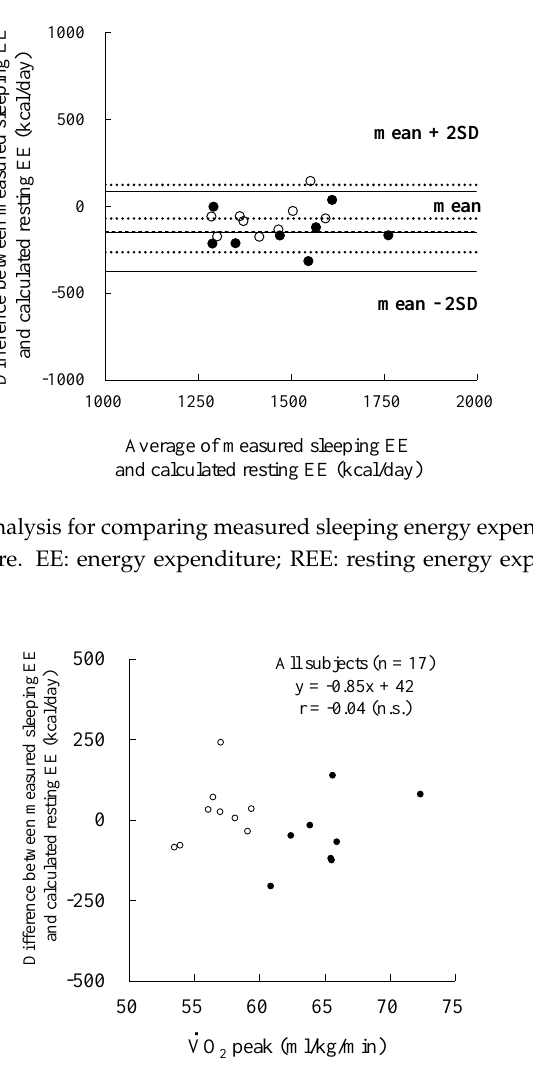
Figure 2. Relationship between the measured sleeping energy expenditure and calculated resting energy expenditure. EE: energy expenditure; REE: resting energy expenditure. Nutrients 2016 , 8 , 196